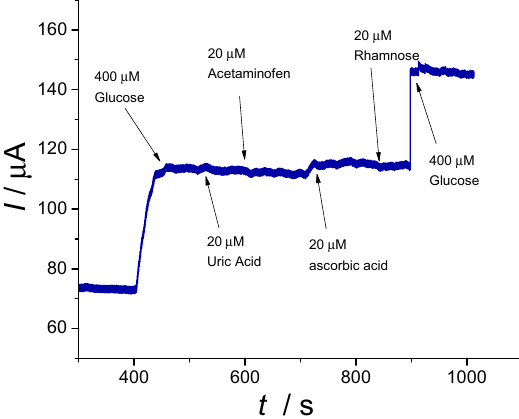
Figure 10. Amperometric responses in 0.1 M NaOH solution with standard additions every 100 s of 400 µM Glu, 20 µM UA, P, AA, R and 400 µM Glu (E p = +0.55 V, 1100 s) for the Cu/Ni f electrode (working electrode area of 25 mm 2 ).